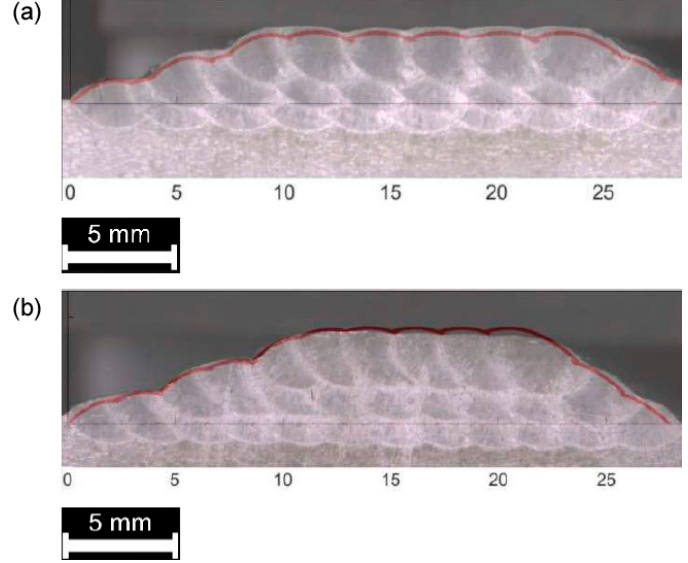
Figure 14. Comparison between theoretical (red, superimposed) and actual profile, multi-track, 3-layer deposition: ( a ) 33% OR ; ( b ) 50% OR .